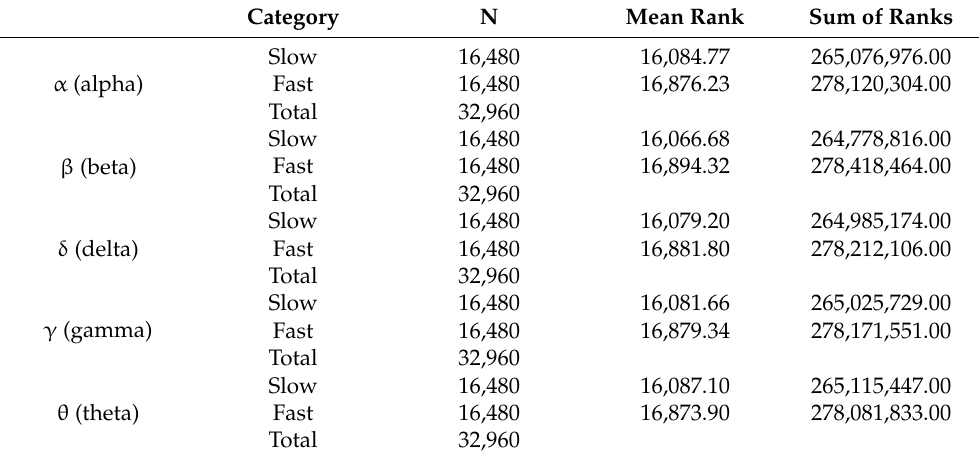
Table A5. Ranks of the mean band measurements related to the Slow and Fast categories for the Movement VDEP.